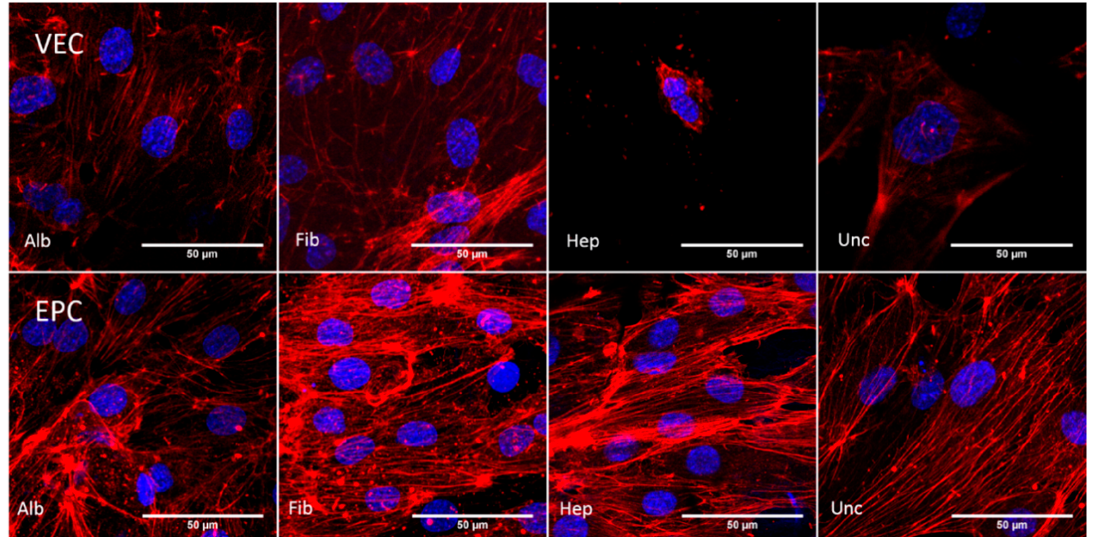
Figure 6. Confocal microscopy images of BNC grafts seeded with vascular endothelial cells (VEC) and endothelial progenitor cells (EPC) under static conditions. Cell nuclei were stained against DAPI (blue) and the F-actin of the cytoskeleton was stained with rhodamine phalloidin (red). All groups seeded with EPCs showed areas with dense colonization and a distinct cytoskeleton. For VECs, it was only in the heparin group that singular cells without pronounced a cytoskeleton were found, while VECs in the other groups showed areas of cells with a regular expansion of the F-actin